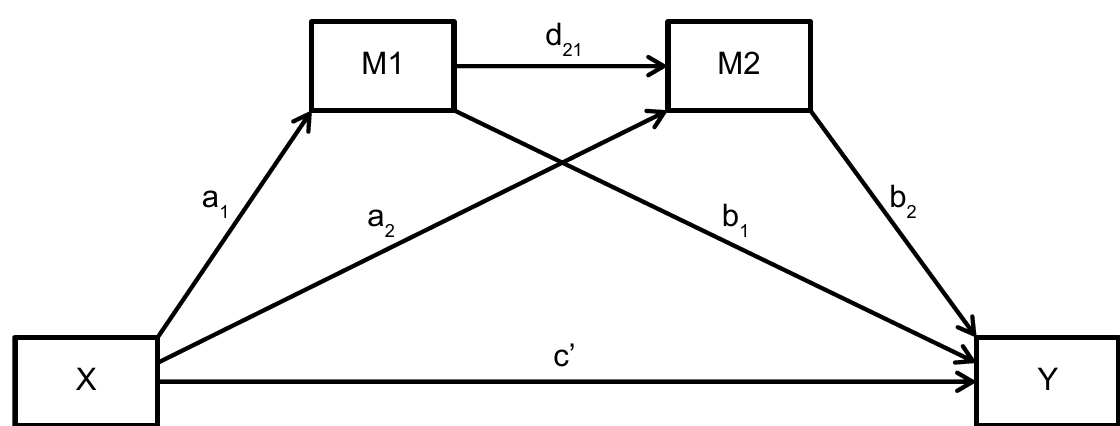
Figure 2. Statistical diagram of multiple mediation model 6 (Preacher & Hayes,